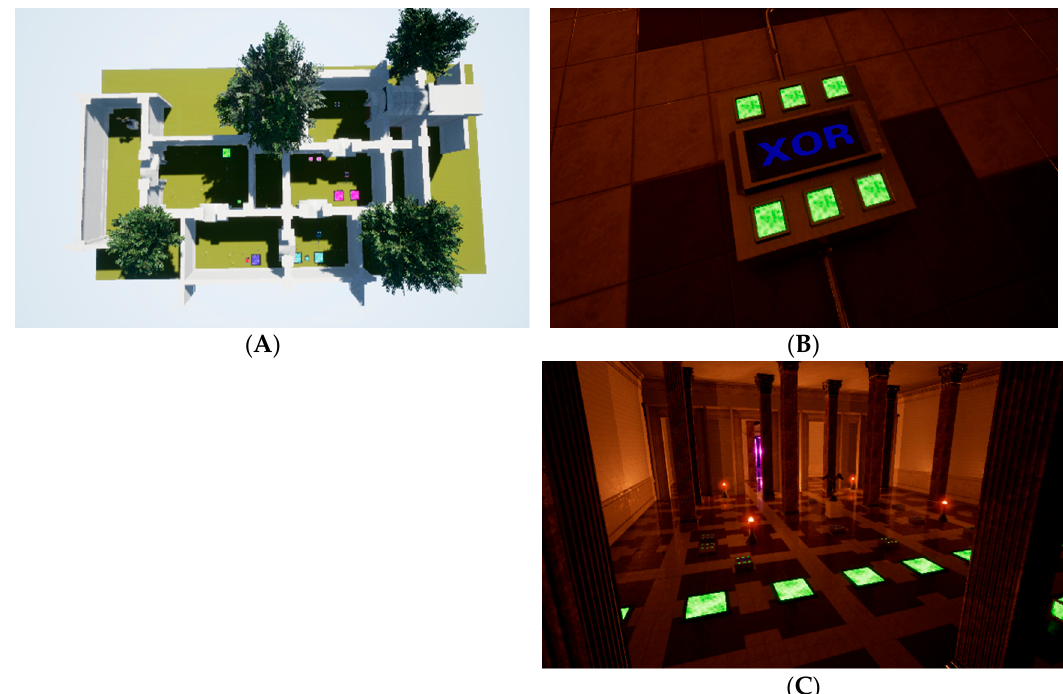
Figure 1. Levels of the serious game (SG): ( A ) “The Garden” (easy difficulty level); ( B ) “Four Doorways” (medium difficulty level); ( C ) and “The Big Hall” (hard difficulty level).